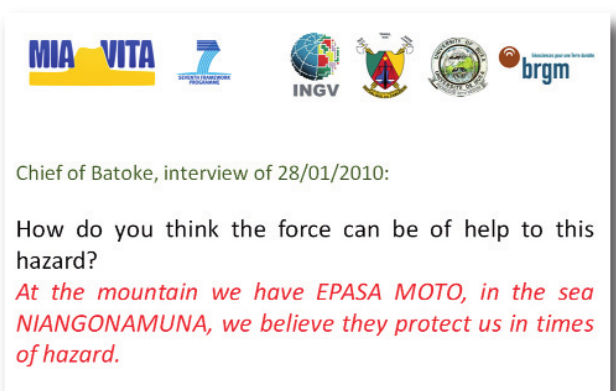
Figure 9. The answers of the Chief of Batoke suggest that despite the efforts of the Cameroon Civil Protection to raise the awareness to face natural hazards, the local risk perception comes from a strong historical memory that is still alive in tales and legends. Resilience strategies are delegated to divine intervention [Pannaccione Apa et al. 2011]. Despite the government ban on these practices, still now human beings are devoted to be sacrificed in some places, as young albino boys, while albino virgins are